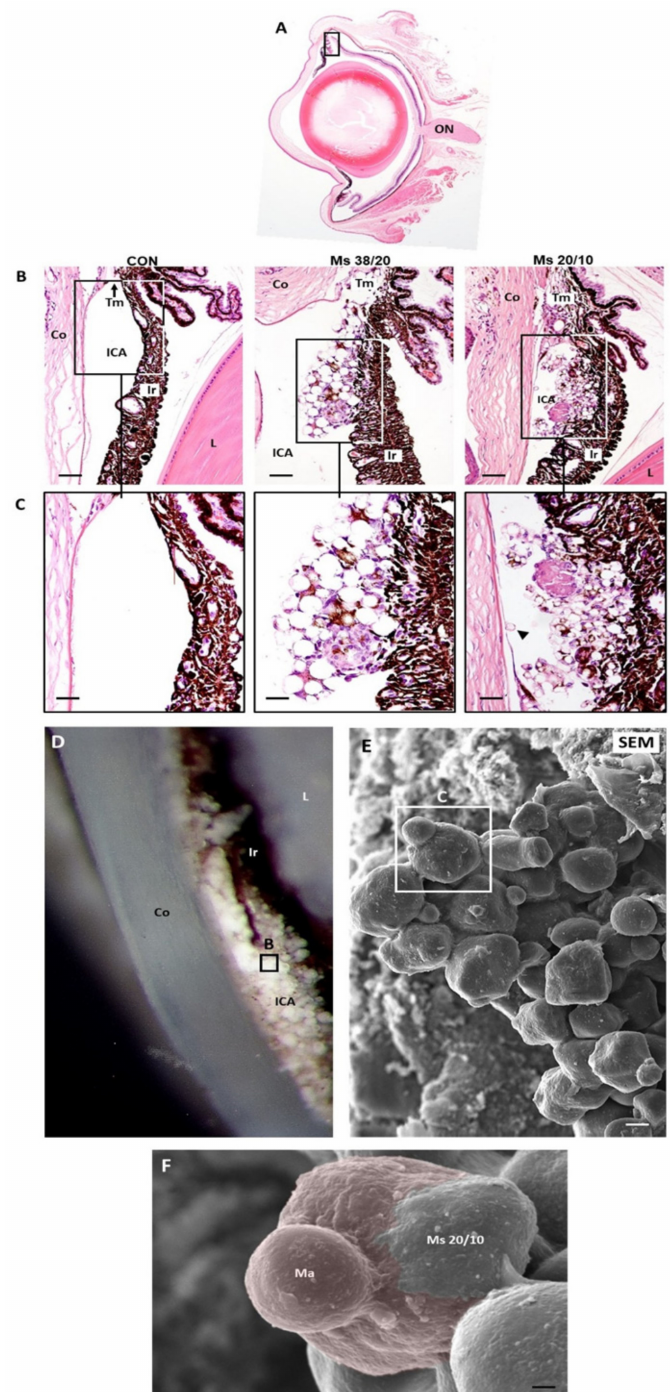
Figure 2. Visualization of microspheres at the iridocorneal angle with Hematoxilin/Eosin and scan- ning electron microscopy. ( A – C ) Localization of microspheres at the iridocorneal angle hampering the trabecular meshwork. Hematoxilin/Eosin histological sections at the level of the optic nerve. Arrowhead: microsphere in contact with the endothelium of the cornea. Scale bars for subfigure ( B ) is 53.47 µ m and for subfigure ( C ) is 6.73 µ m. ( D – F ) Dissection of the iridocorneal angle. The cornea has been sectioned and removed leaving the anterior eye chamber visible. Notice the whitish appearance of the microspheres. ( E , F ) Scanning electron microscopy images. In ( F ) an aggregate